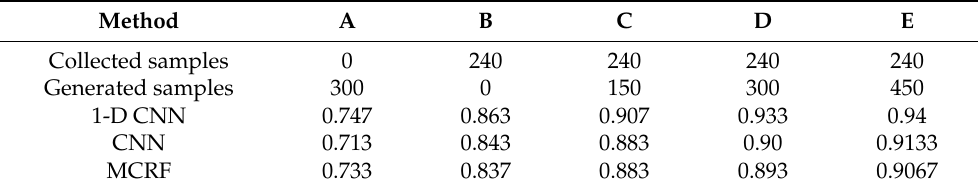
Figure 12. The confusion matrices of diagnosis result. Table 3. Diagnostic results with different amount of generated samples.